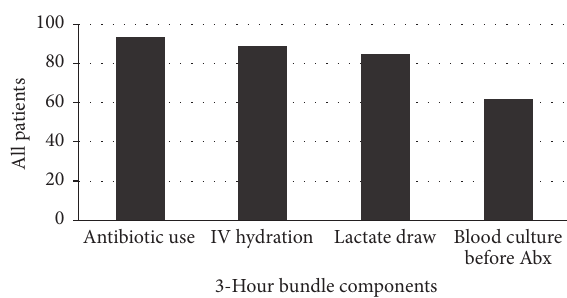
Figure 1: Compliance with individual components of 3-hour bun-